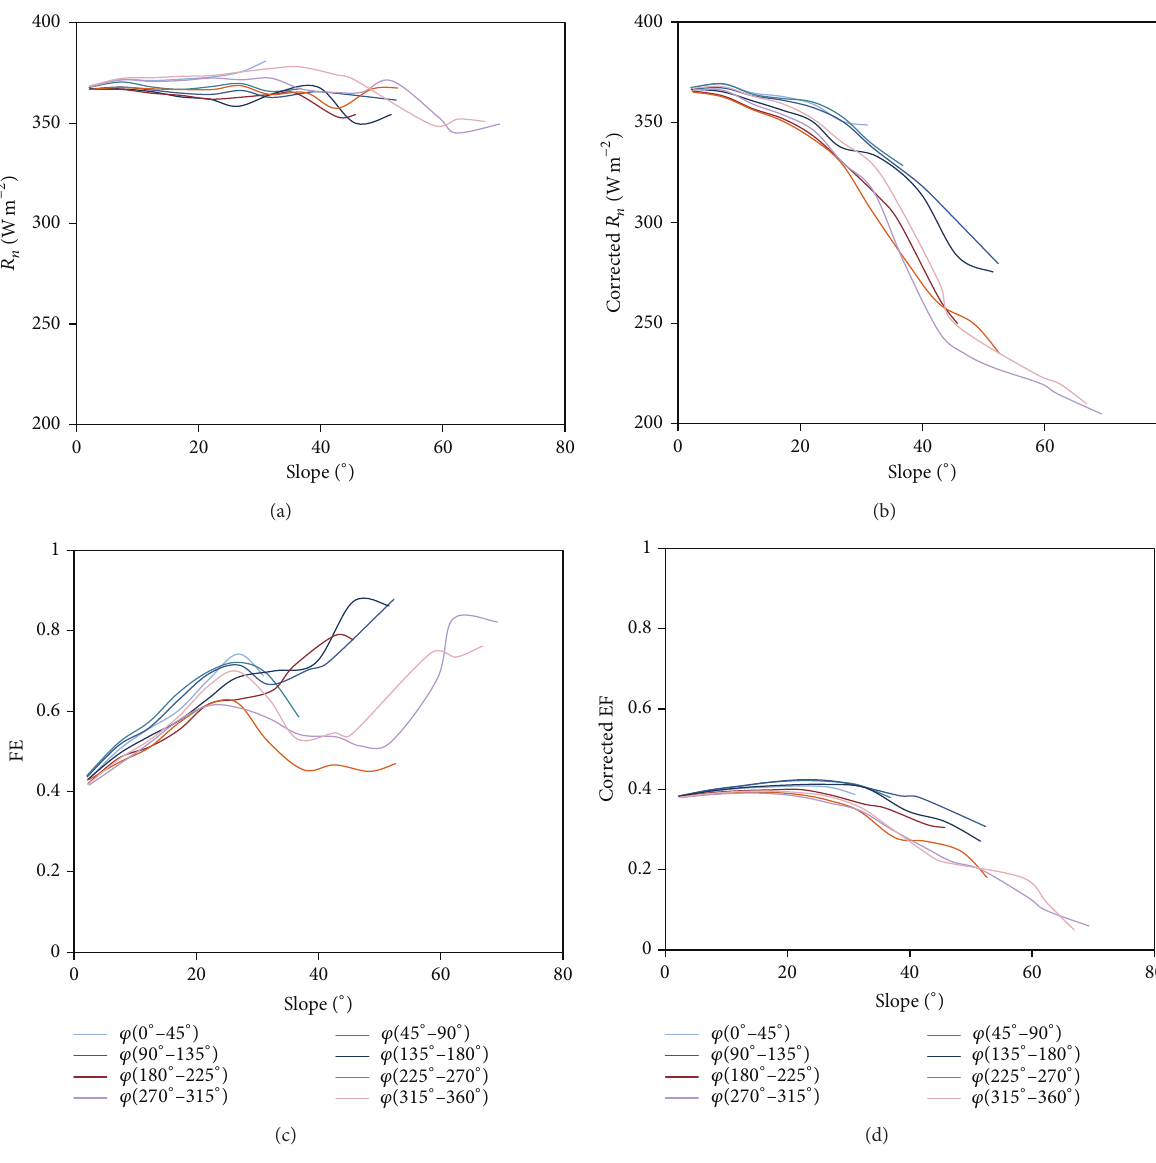
𝑅 𝑛 after topographic correction, (c) EF before topographic correction, and (d) EF after topographic